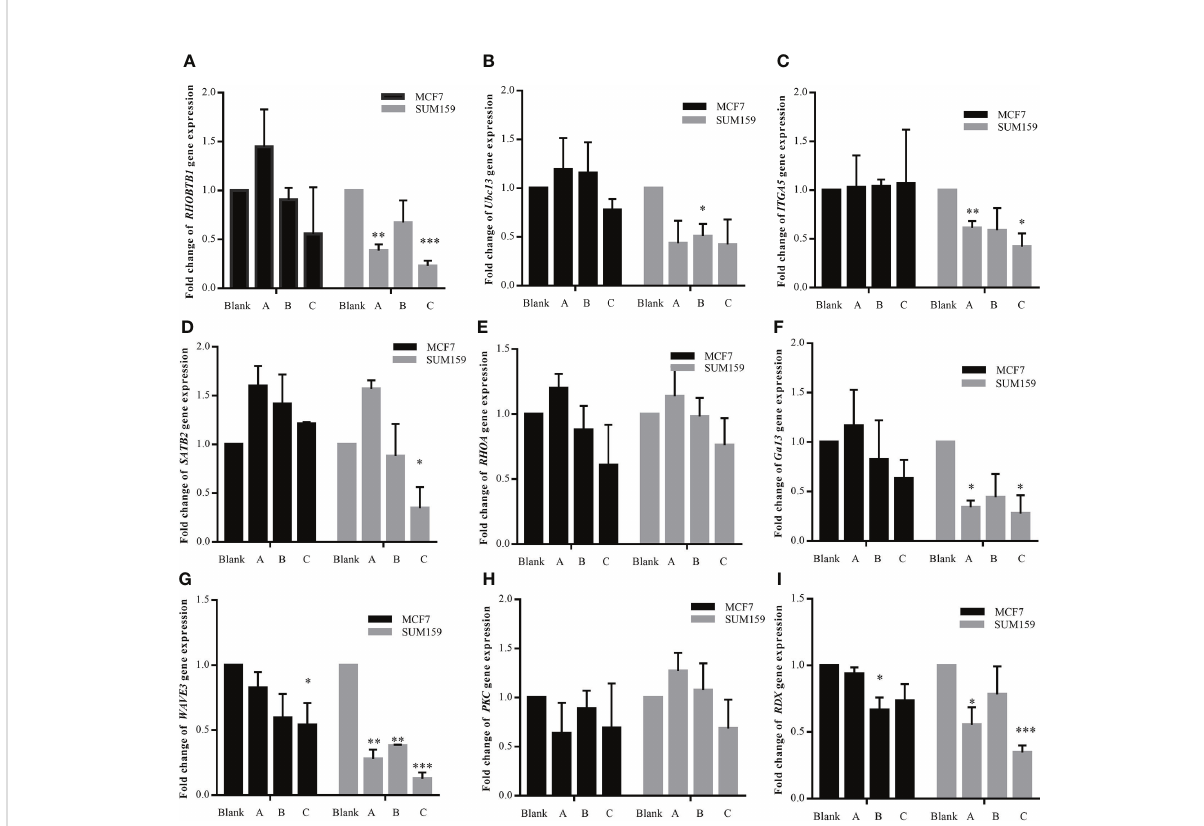
FIGURE 7 (A – I) Effect of combination treatment with GBK and DDP on miR-31 target gene expression. The effect of combination treatment with GBK and DDP on the expression of miR-31 target genes was detected by RT-qPCR. Three experimental groups were established, 1 m g/ml DDP (group A), 1 m g/ml DDP and 1 m g/ml GBK (group B), and 1 m g/ml DDP and 5 m g/ml GBK (group C). Double distilled H 2 O was added to the control group (Blank). Black bars indicate MCF-7 cells and gray bars indicate SUM-159 cells. Data are presented as mean ± s.e.m. of three